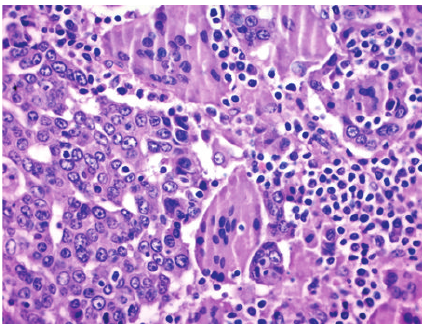
Figure 2: Osteoclastic giant cells with bland nuclei and lack of atypia. There is also an accompanying lymphocytic infiltrate. H&E stain, × 400.